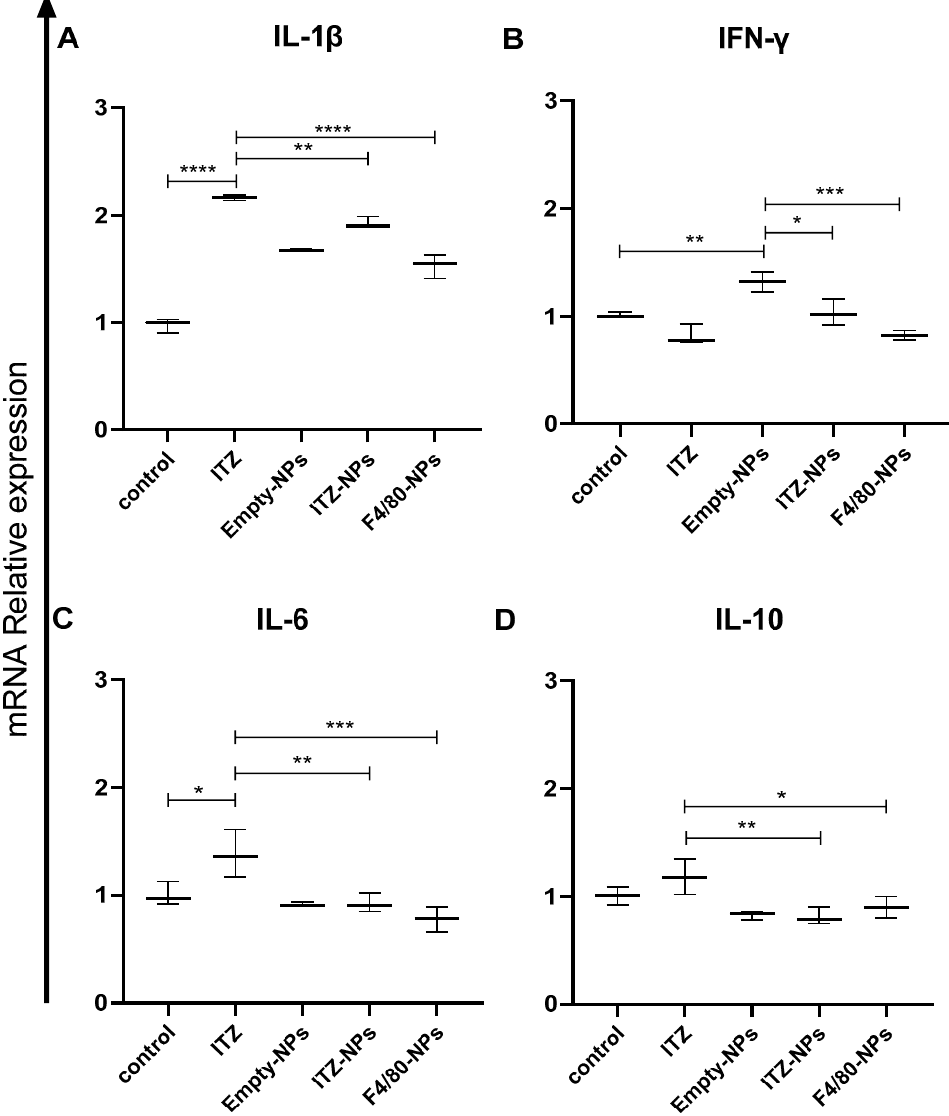
Figure 6. Immunomodulation effect of ITZ encapsulated into anti-F4/80-antibody-functionalized PLGA75:25-TPGS-pH5 NPs in co-culture of J774A.1 with H. capsulatum after 6 h of treatment. Expres- sion of ( A ) IL-1 β , ( B ) IFN- γ , ( C ) IL-6, and ( D ) IL-10. *, **, *** and **** indicate statistically